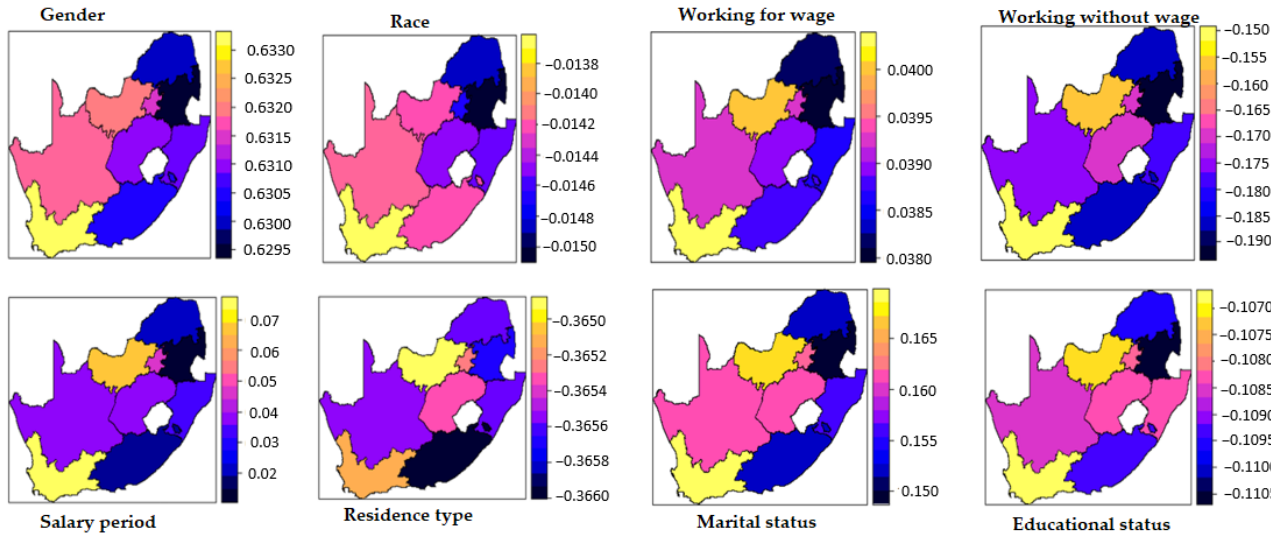
Figure 3. Spatial varying effects of covariates on hypertension.